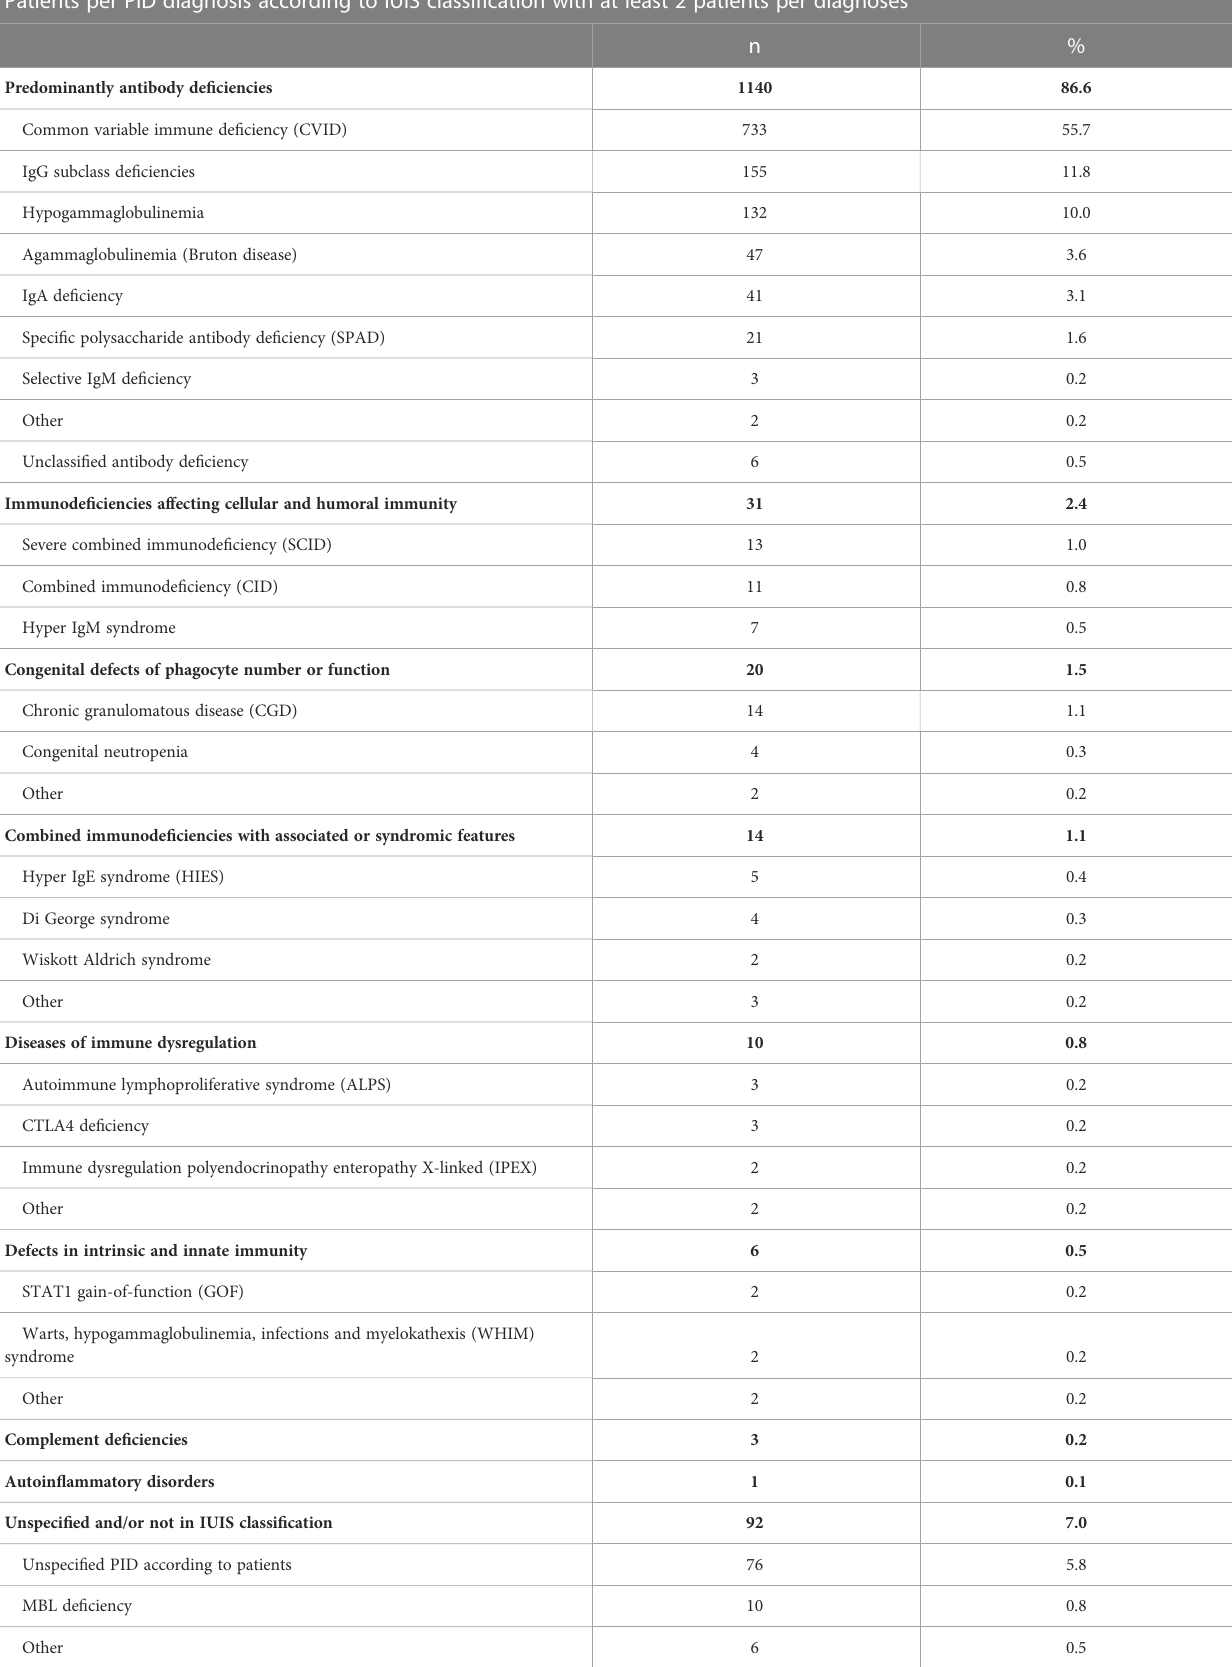
TABLE 2 IUIS* diagnostic groups categorizing the PID patients represented in the